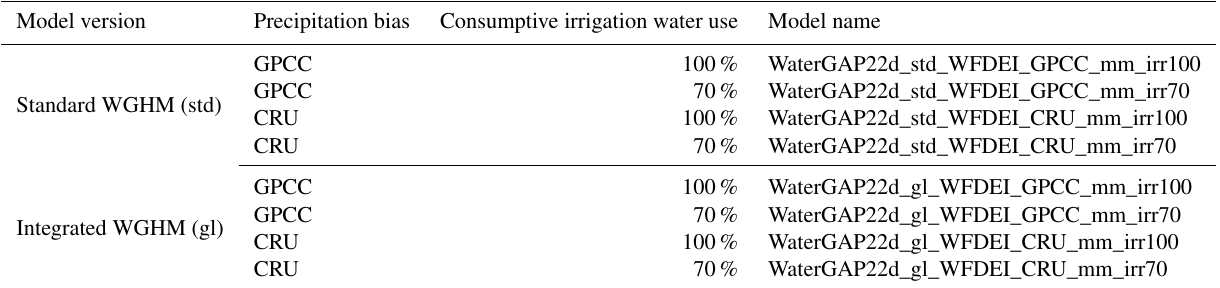
Table 1. Summary of WGHM 2.2d versions used in this study. The integrated WGHM version is standard WGHM with an additional glacier module from GGM. An average of four variants in each version were used in the study. Model